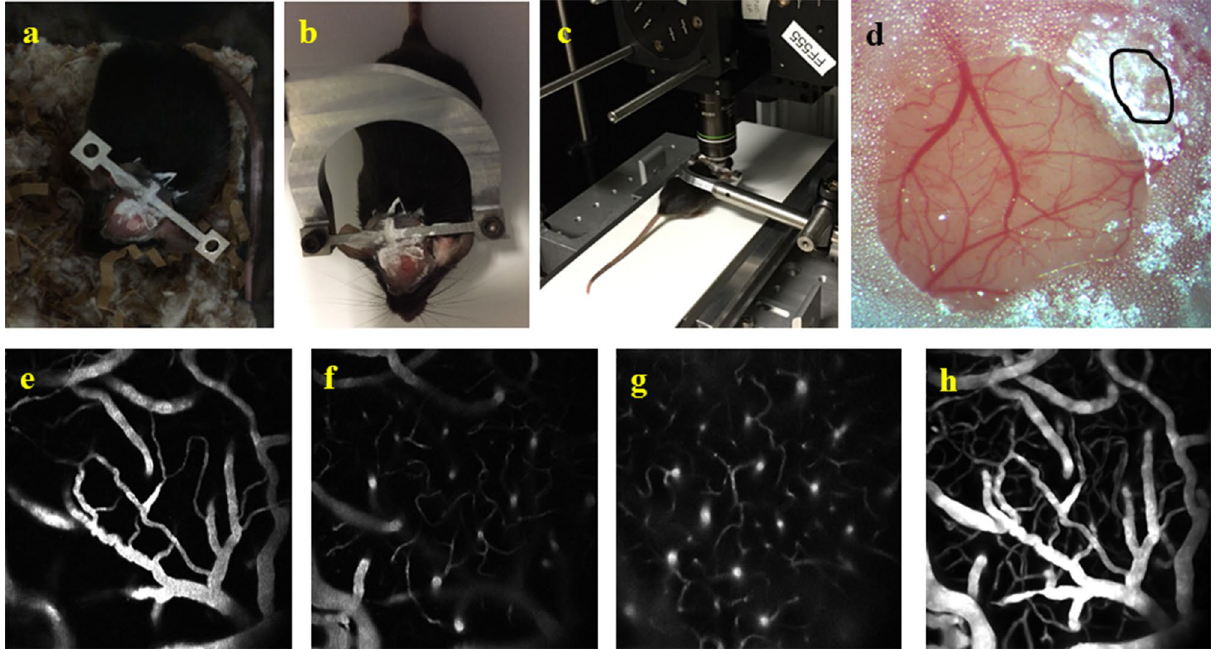
Figure 1. (a) A custom head-plate made from titanium was glued to the skull to allow animal restraint on the treadmill. (b) The implanted titanium bar was screwed to a holder to fix the animal’s head. (c) Restrained animal on the motorized treadmill under two-photon setup. (d) Thinned skull cranial window preparation with a small thinned region next to the coverslip uncovered by dental cement (marked with black lines) for pO 2 dye injection. (e–g) Representative two-photon fluorescent images of microvasculature (600 µm × 600 µm) at depths of ~ 20, 50 and 120 μm. (h) En face maximum intensity projection (MIP) of the 3D microvascular angiogram through the depths 0–150 μm.